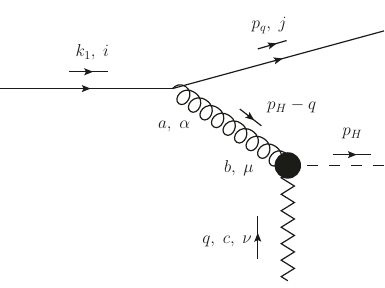
Figure 7 . Feynman diagram contributing to the q R → q H